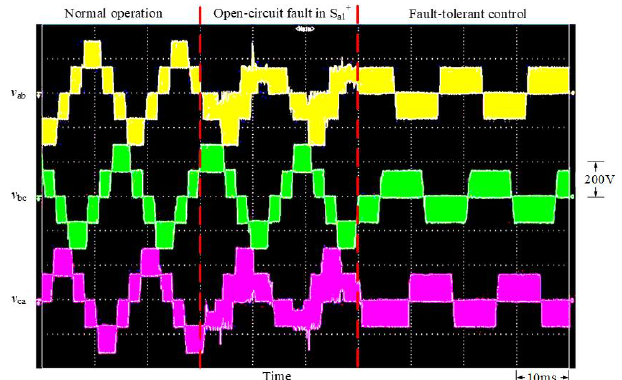
Figure 22. Measured waveform of the output voltage generated by the fault-tolerant control strategy when an open-circuit fault occurs in the switch S a 1 +.